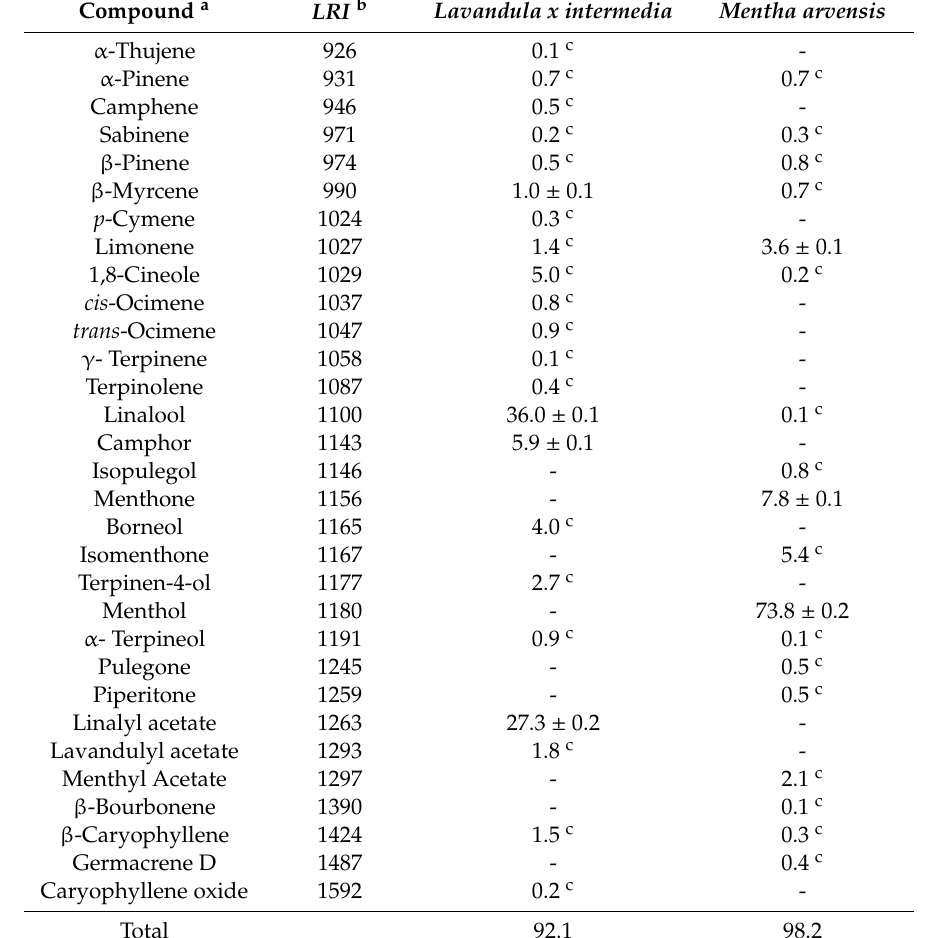
Table 1. Qualitative and semi-quantitative analysis of Lavandula x intermedia and Mentha arvensis essential oils (EOs). Data are expressed as % relative peak area values ± standard deviation